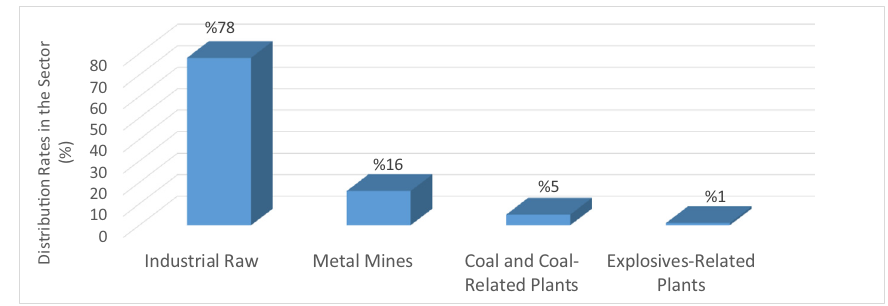
Figure 6: Type distribution for mining - related EIA